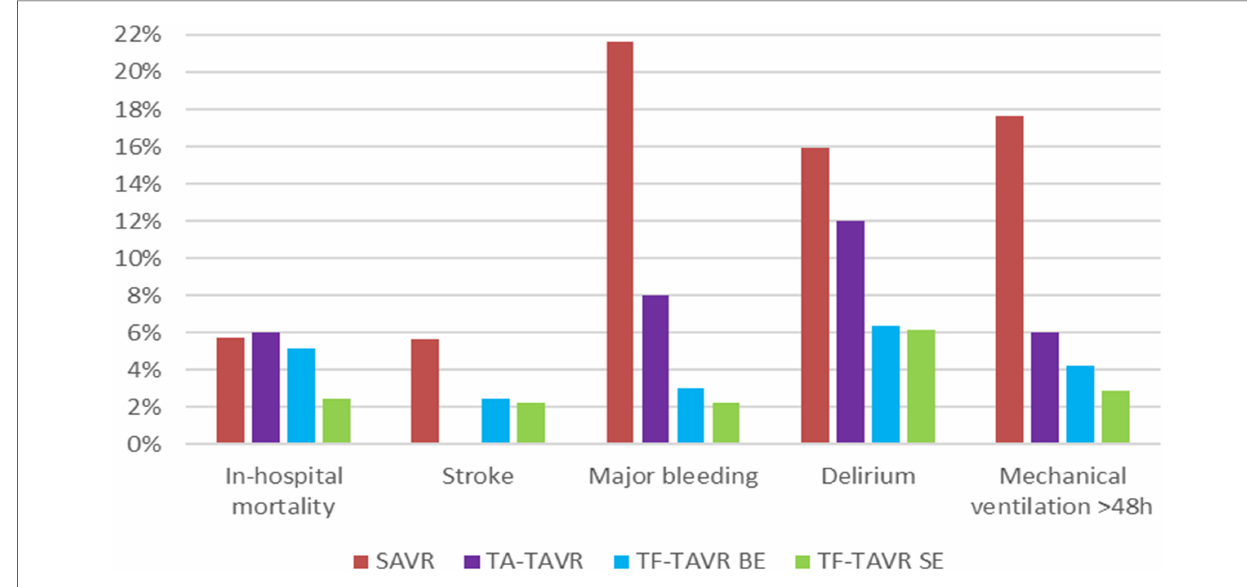
FIGURE 2 Unadjusted in-hospital outcomes of patients treated for aortic regurgitation between 2018 and 2020 in Germany. BE, balloon-expandable; SAVR, surgical aortic valve replacement; SE, self-expanding; TA, transapical; TAVR, transcatheter aortic valve replacement; TF,